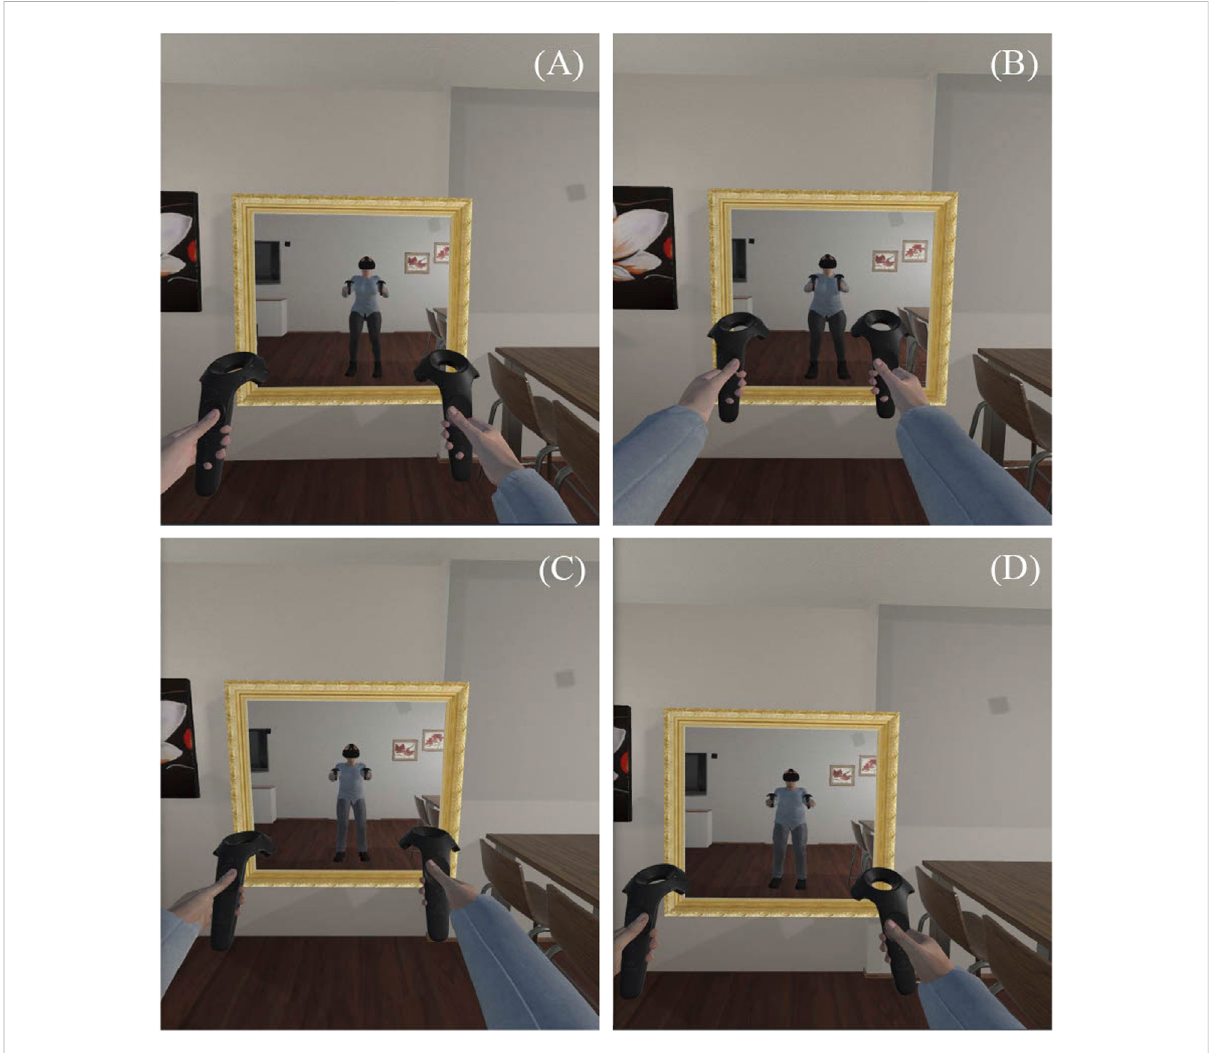
FIGURE 2 Healthyweightandoverweightmaleandfemaleavatar,presentedfromtheparticipant ’ sperspective.Note. (A) Femalehealthyweightavatar, (B) Female overweight avatar, (C) Male healthy weight avatar, (D) Male overweight